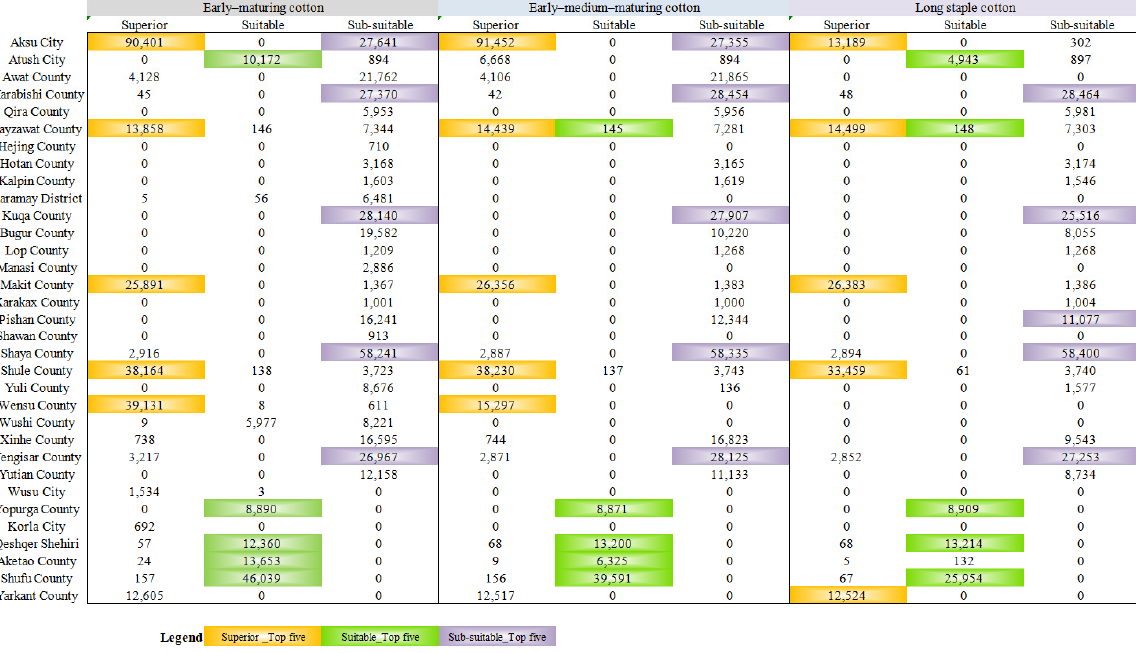
Figure 12. Suitable area of cotton seed production in different counties. (unit: